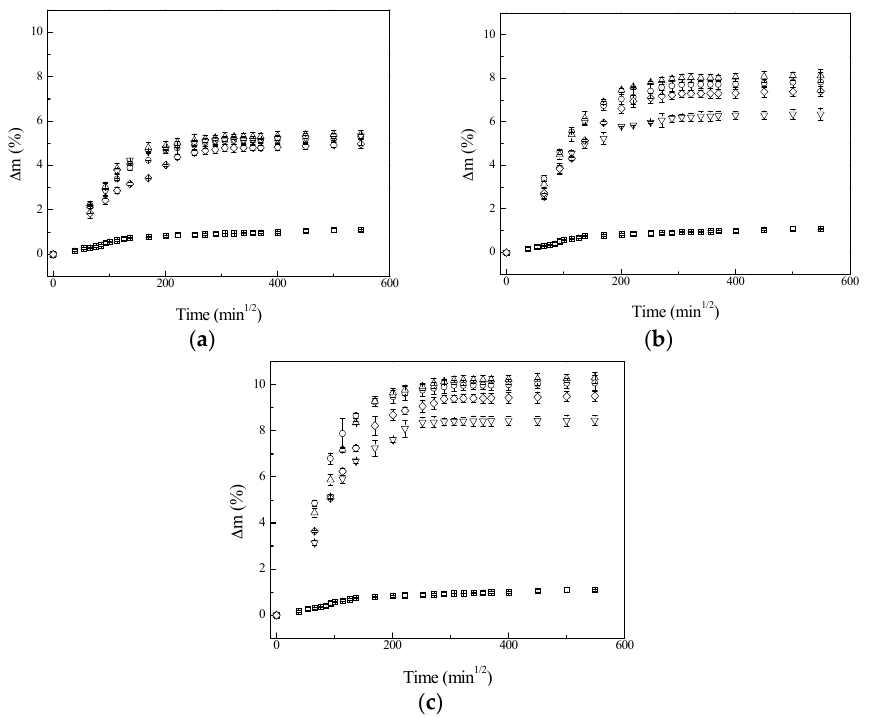
Figure 3. Water uptake profiles for composites as a function of square root of immersion time for different fiber surface treatments and fiber content: ( a ) 20 wt %; ( b ) 30 wt %; and ( c ) 40 wt %. ( ▫ ) Poly(lactic acid), ( ◦ ) Untreated, ( Δ ) Silane, ( ∇ ) NaOH and ( ◊ ) NaOH + silane.